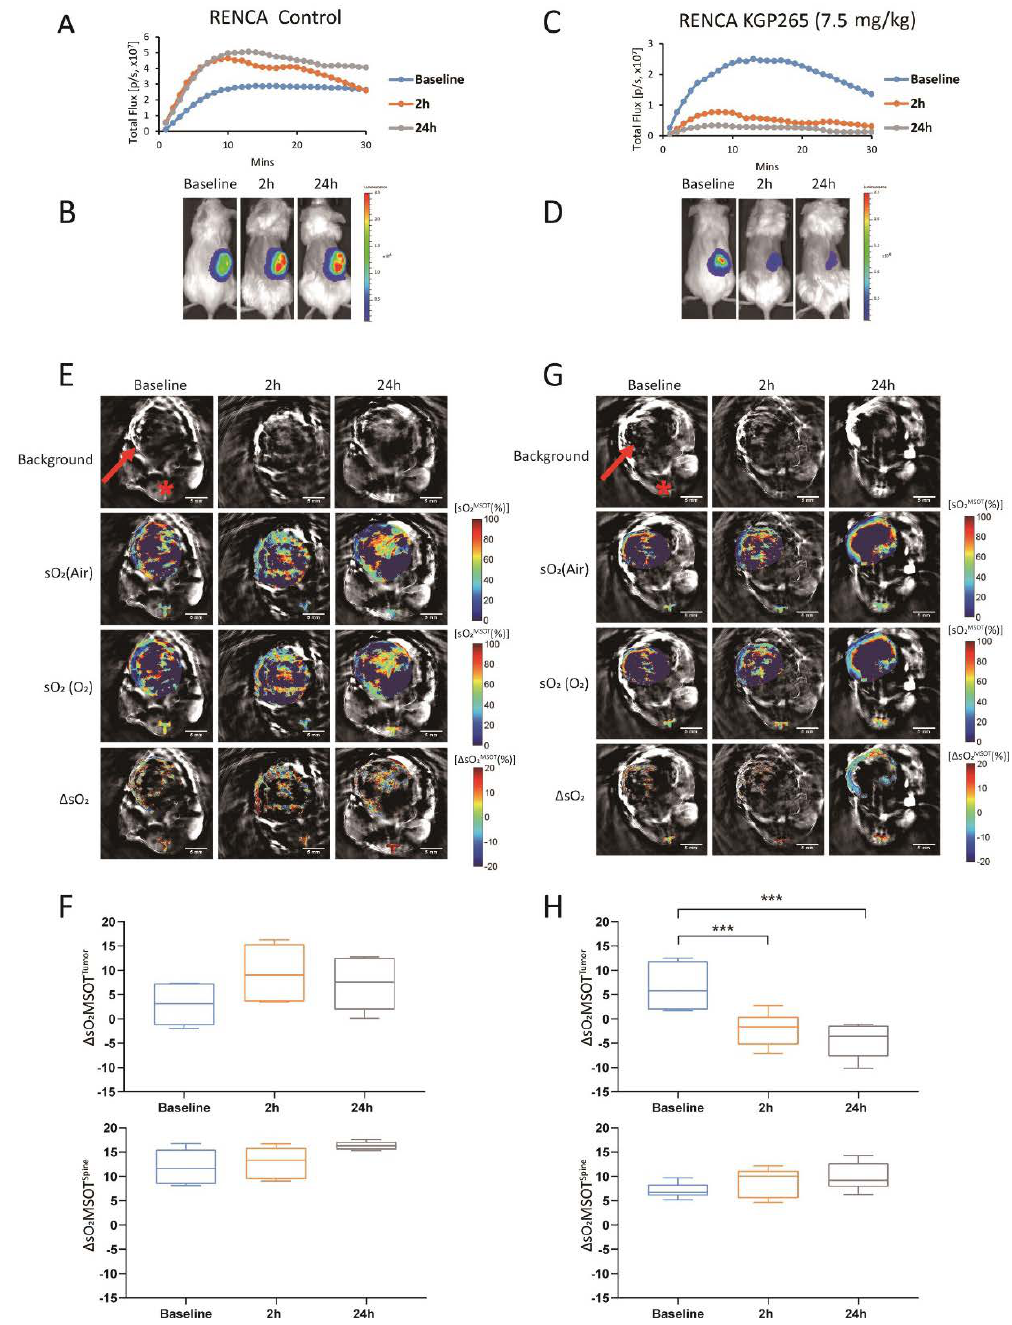
Figure 5. BLI and OE-MSOT of the RENCA-luc orthotopic kidney tumor response to KGP265. ( A , C ) BLI intensity curves for individual mice showing differential variations over a period of 30 min following the administration of luciferin at the baseline (blue), 2 h (orange) and 24 h (grey) following the administration of saline or KGP265 (7.5 mg/kg). ( B , D ) BLI signal intensity images overlaid as heat maps on gray-scale photographs of the BALB/c mice in ( A , C ), respectively, at about 10 min following the administration of luciferin at selected time points following the administration of saline or KGP265; all intensity maps have the same heat scale. ( E , G ) MSOT images showing cross-sections of RENCA tumor-bearing mice with respect to saline or KGP265 (7.5 mg/kg): background single wavelength (800 nm) image showing anatomical details with parametric maps below. The spine ROI is indicated by the red star, and the tumor ROI is indicated by the red arrow. Spatial distribution of the oxygen saturation when the mouse breathed air (sO 2MSOT (Air)) or during the oxygen challenge (sO 2MSOT (O 2 )), and the magnitude of the response (ΔsO 2 ) for each time course from breathing air to breathing 100% oxygen.